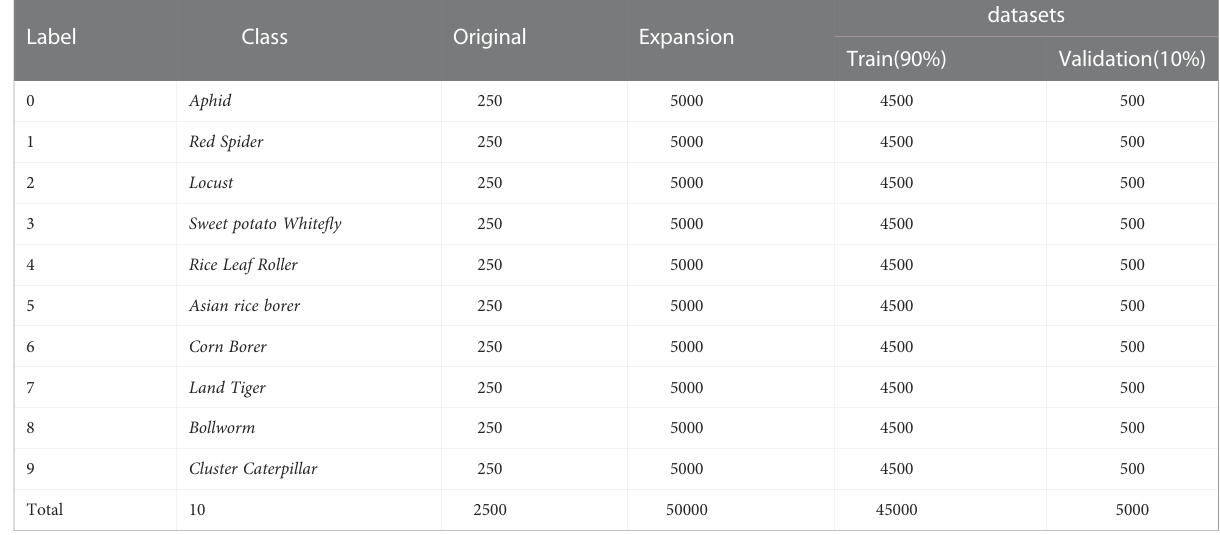
TABLE 1 Image amount of each insect species in the dataset (Random sampling from each category of insects).